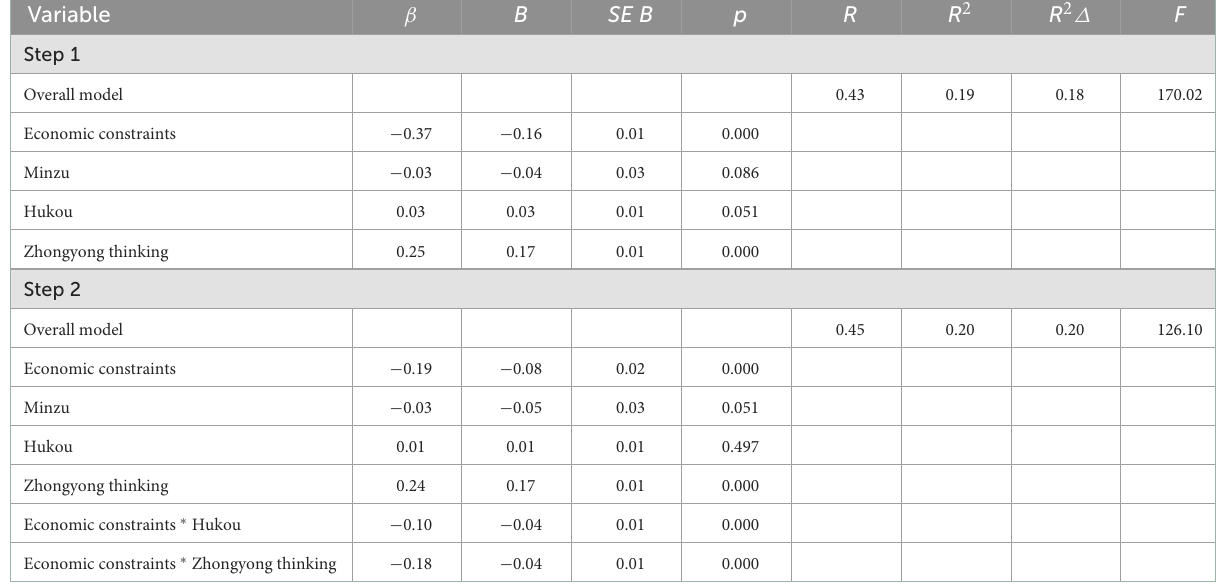
TABLE 2 Hierarchical regression examining the relationship among economic constraints, minzu, hukou, Zhongyong thinking, and work volition.